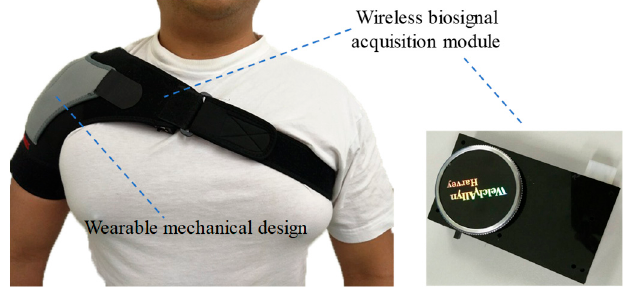
Figure 3. Photograph of the mechanical design in the wearable multiparameter acquisition device.